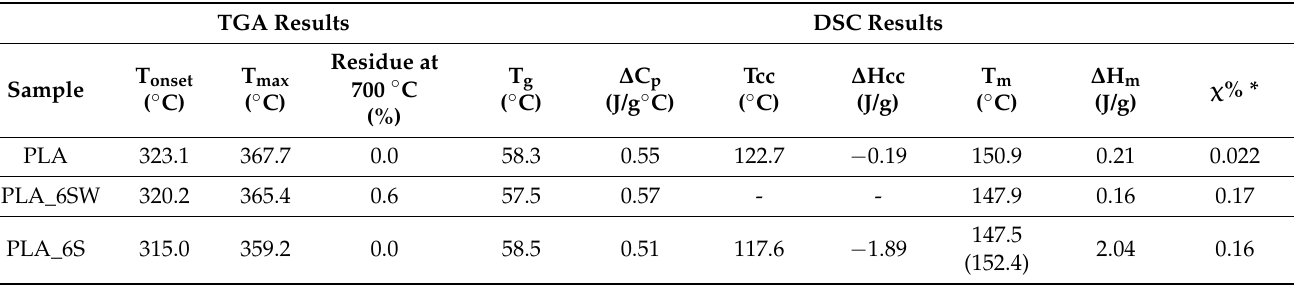
Table 7. TGA and DSC results of PLA samples.